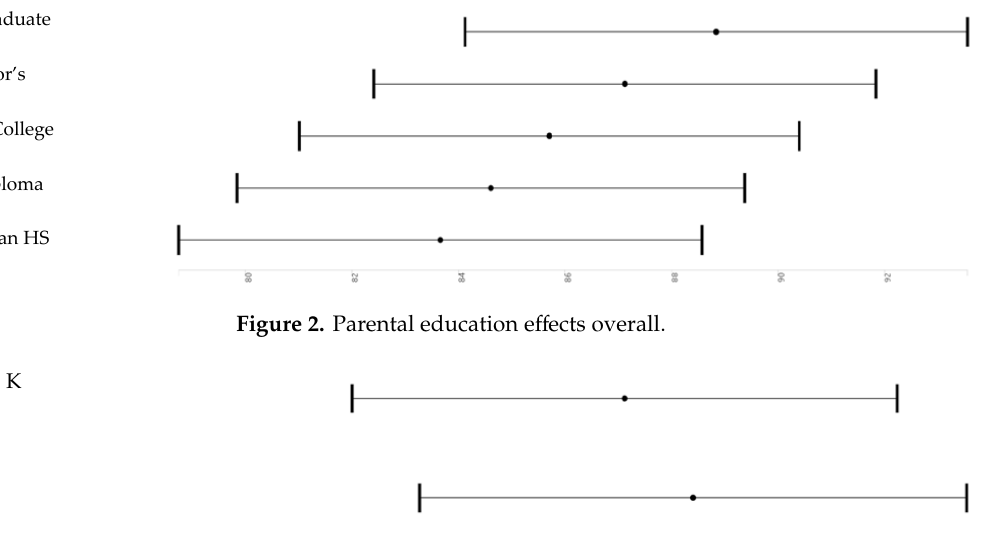
Figure 2. Parental education effects overall.